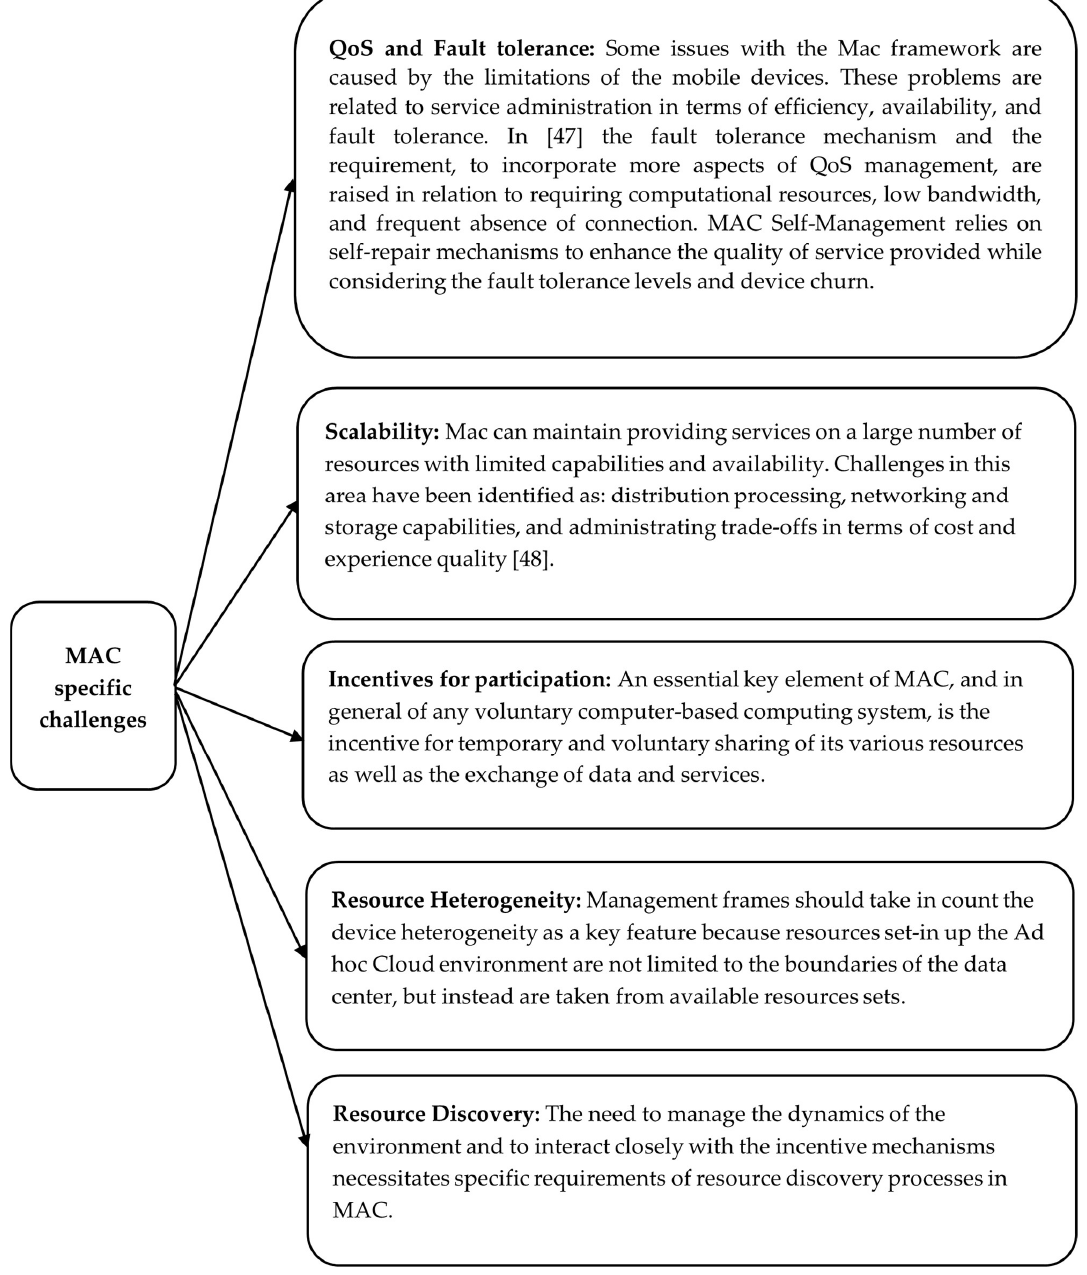
Figure 1. MAC specific challenges.